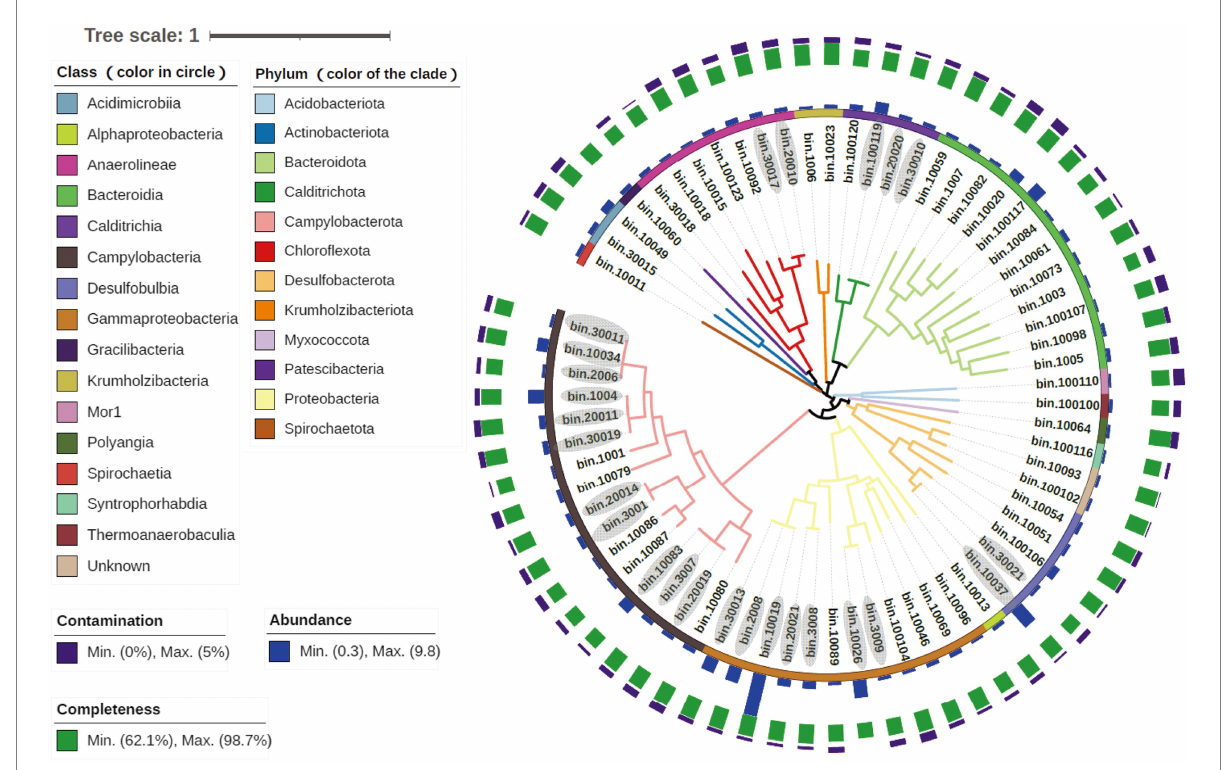
FIGURE 4 Information of all the reconstructed 69 MAGs. The colors of clades were responding to the phyla taxonomic level, while the first circle were family level. MAGs ID stating with “100” were restructed from meatgenomics of W1, “200” from W2 and “300” from W3. As the MAGs ID stands for the source of sample, their abundance referred to the ratio of that MAG’s mean coverage to that sample’s overall mean coverage. The MAGs ID with grey color own ANI value of 90 ~ 99% calculated by